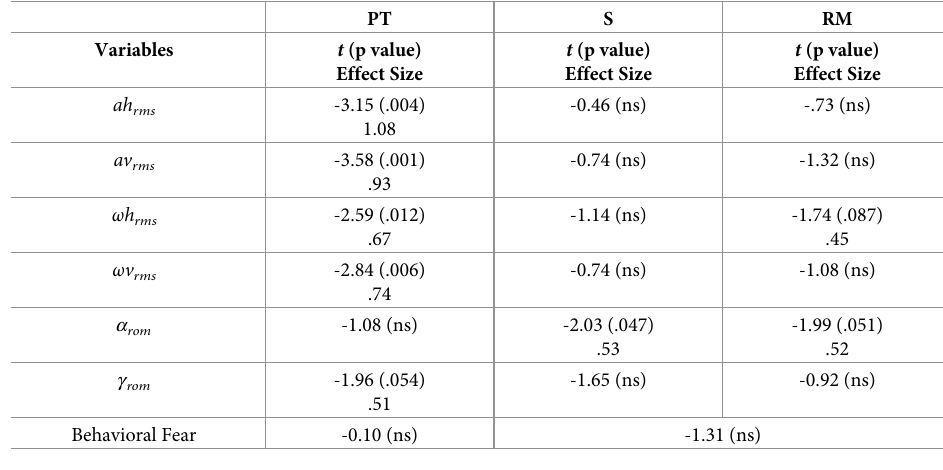
Table 6. Motion and coded behavioral fear differences between children with and without internalizing diagnoses. PT S RM Variables t (p value) t (p value) t (p value) Effect Size Effect Size Effect Size ah rms -3.15 (.004) 1.08